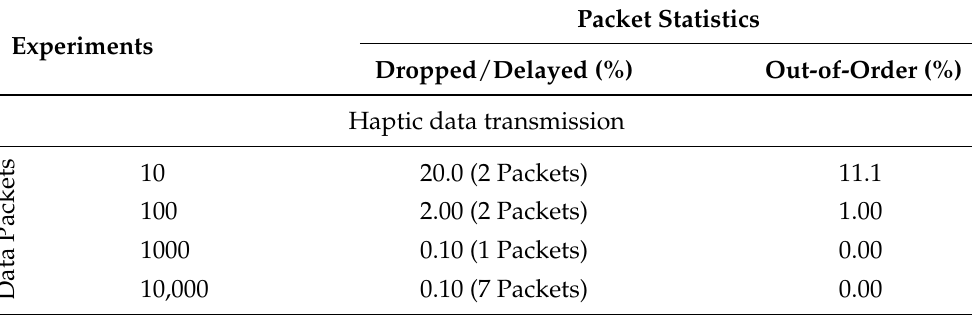
Table 3. Summary of the reliability characterization for haptic datset and real-time haptic drive teleoperation